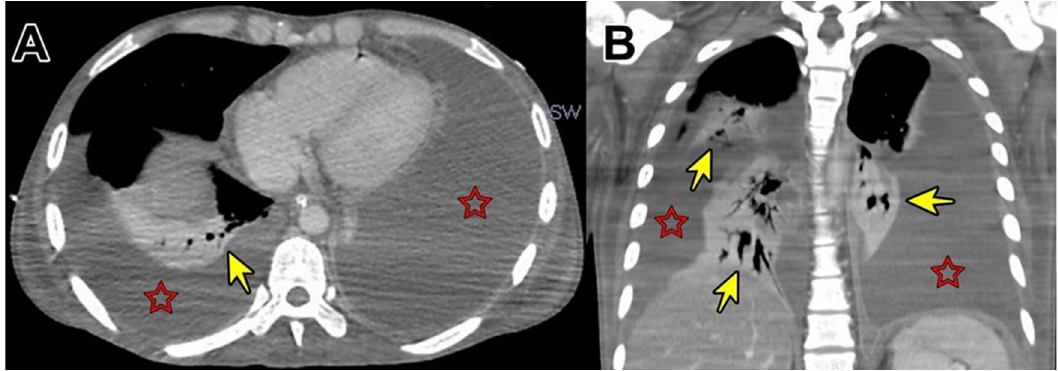
Figure 6. Contrast-enhanced computed tomography showing massive pleural effusion (red stars) with consolidation of both lungs (yellow arrows) (A and